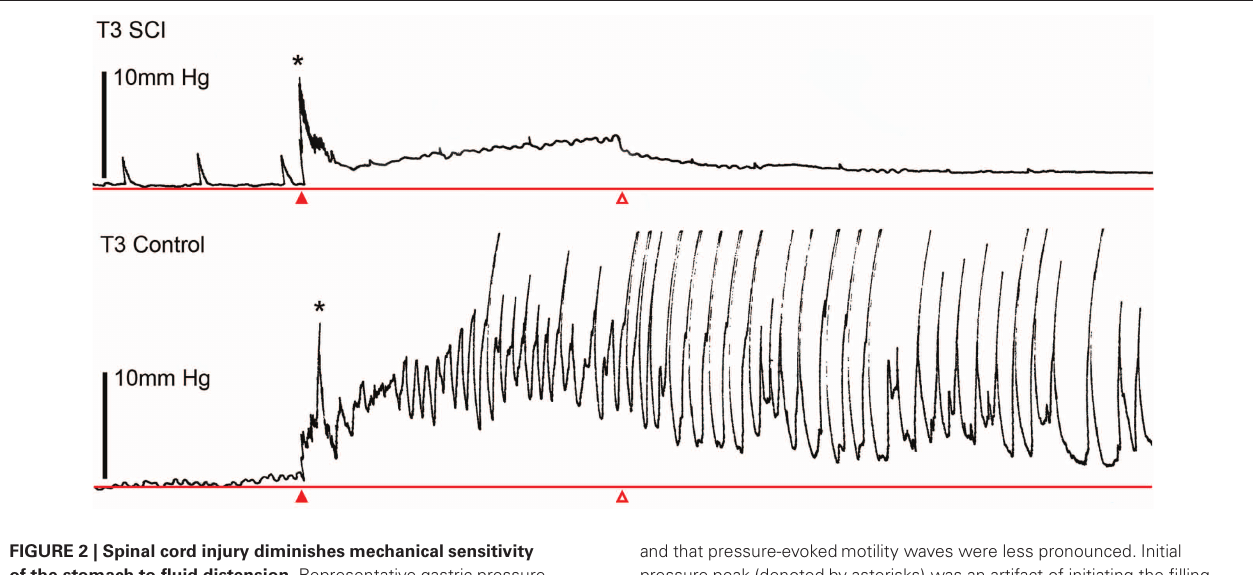
and that pressure-evokedmotility waves were less pronounced. Initial pressure peak (denoted by asterisks) was an artifact of initiating the filling cycle. Gastric distension was maintained at the termination of the filling cycle. Distension was performed by passing a saline-filled catheter via an incision in the proximal duodenum and through the occluded pylorus. The lower esophageal sphincter was untouched and maintained closure at the gastric